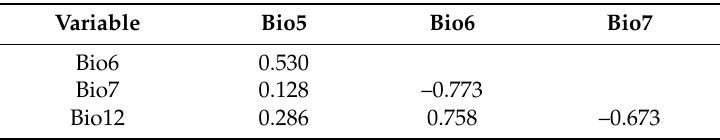
Table A3. Pearson correlation coefficients ( r ) among four bioclimatic variables calculated using the Band Collection Statistics tool in ArcGIS 10.3.